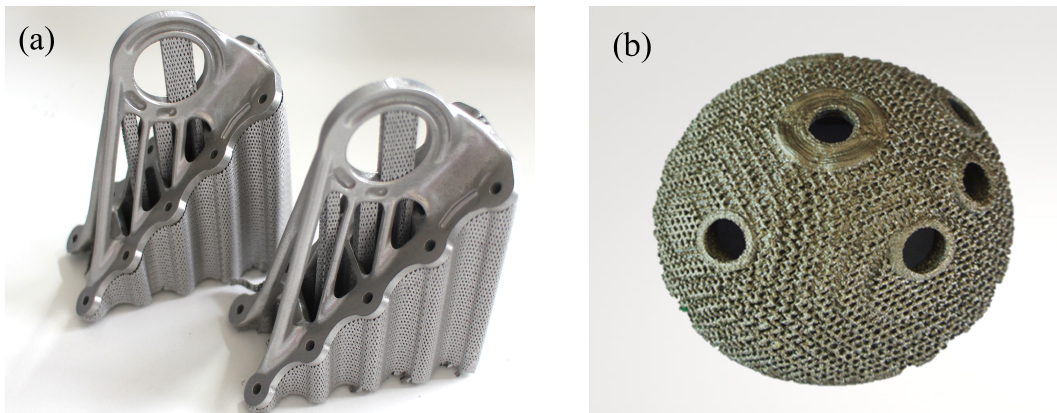
Figure 5. Titanium components manufactured by powder bed fusion metal additive